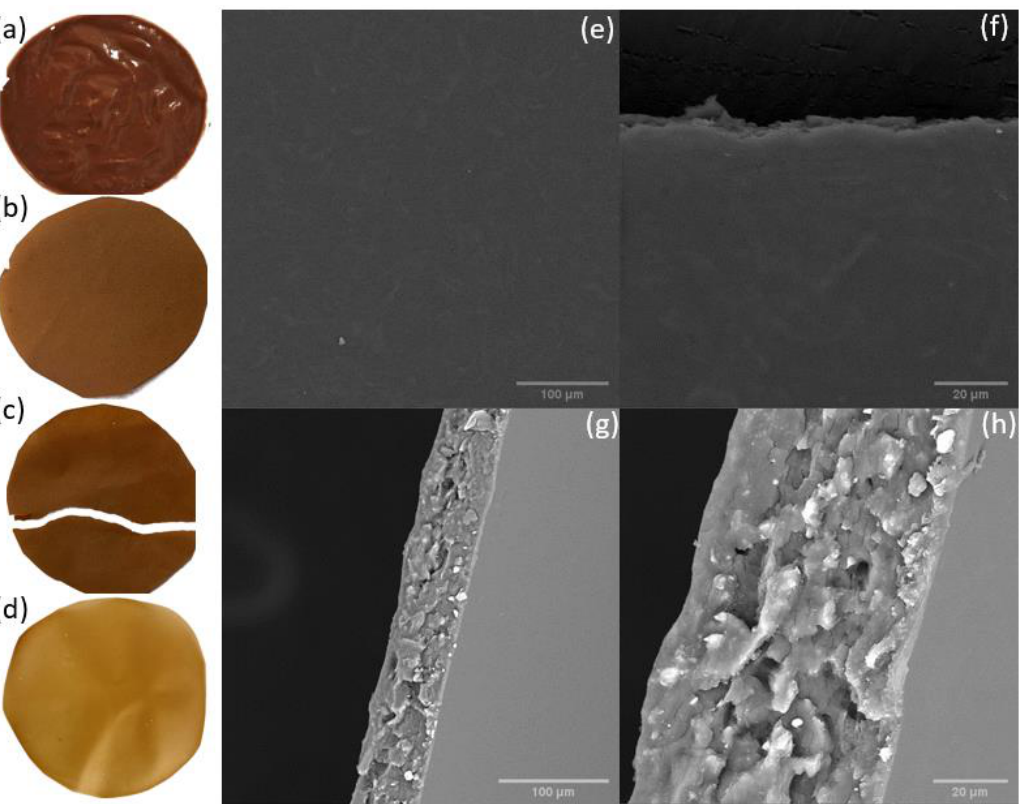
Figure 2. ( a ) MFC gel suspension of pinh ã o seed coat 6% wt%/v with gel-like characteristics; ( b ) a film produced using the gel suspension and water using the sieve method, dried overnight at 60 ◦ C; ( c ) demonstration of how the film is brittle and ( d ) film produced using MFC gel suspension of pinh ã o seed coat 1% wt%/v with 5% of PVA by casting method, dried overnight 60 ◦ C. Scanning electron microscope images for surface ( e ) 500 × , ( f ) 2000 × and cross-section ( g ) 600 × , ( h ) 2000 × for films produced using MFC gel suspension of Pinh ã o seed coat 1% wt%/v with 5% of PVA by casting method.